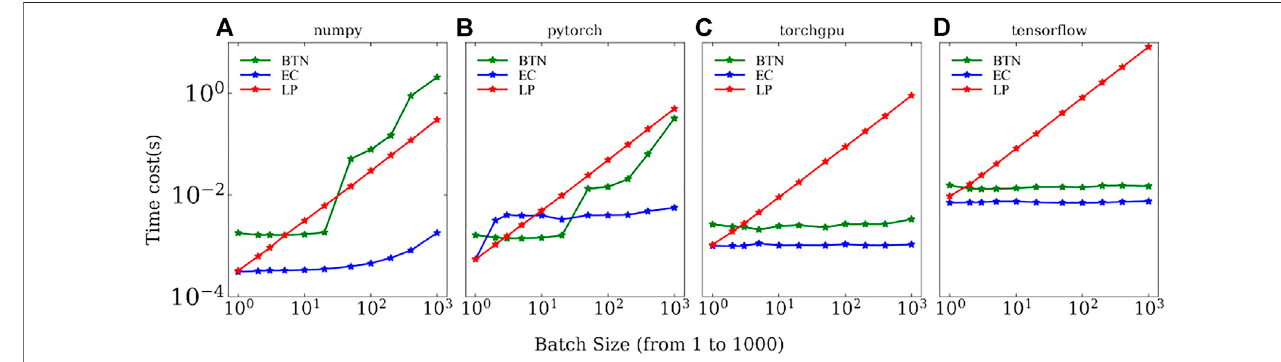
FIGURE8| Speed-upbenchmarkresultsfordifferentmethodsasafunctionofbatchsizewith: (A) NumpyonCPU; (B) PyTorchonCPU; (C) PyTorchonGPU;and (D) Tensor fl ow on GPU. The red, blue, and green solid lines correspond to the result obtained using the loop method (LP), ef fi cient coding (EC), and the batch tensor network method (BTN), respectively. All the panels are plotted in the log — log format. The result is tested on an Intel(R) Core(TM) i7-8700K CPU and 1080Ti